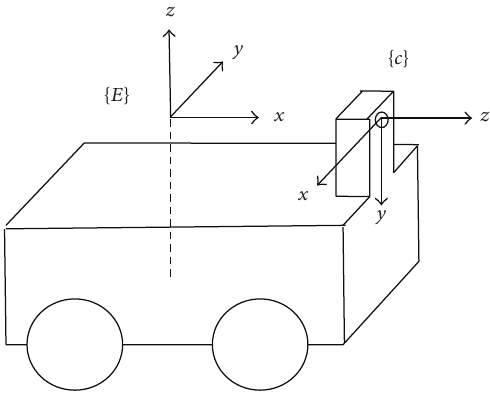
Figure 2: The mobile robot frame and the camera frame.